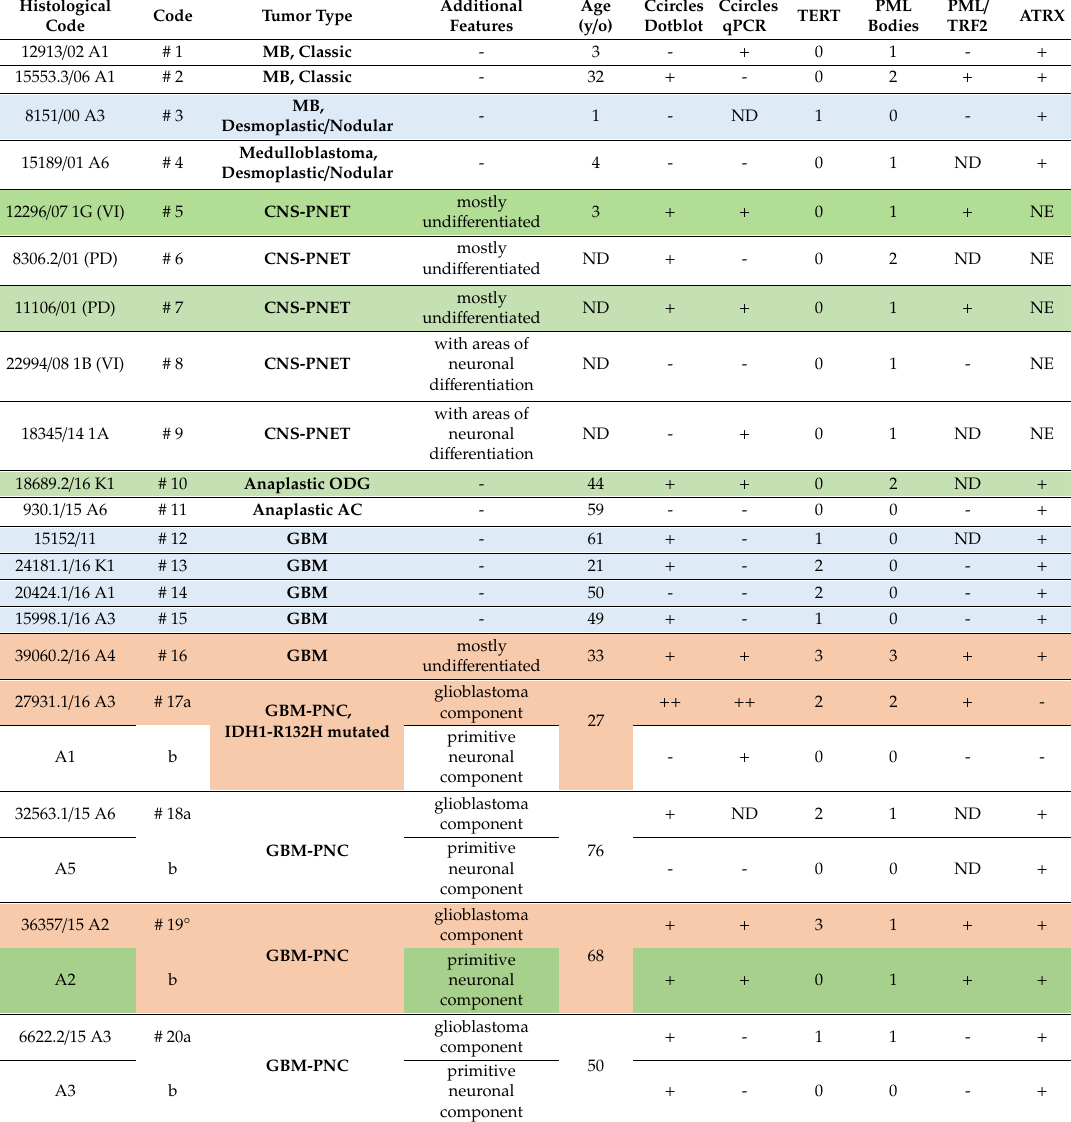
Table 1. Identification of TMMs in a panel of twenty human brain